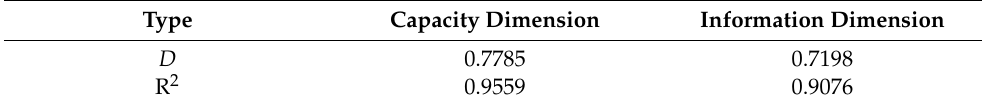
Table 3. The determining data of grid dimension of Fuzhou park